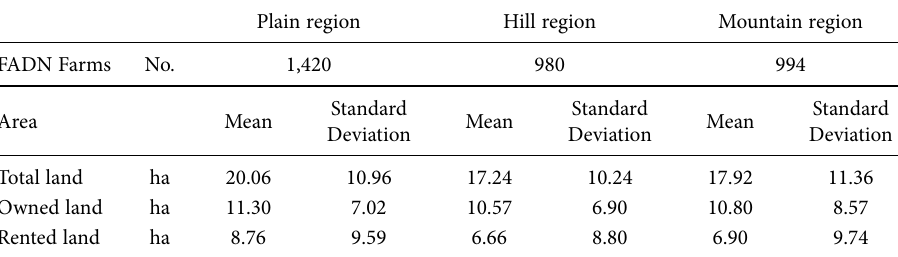
Table 3. Area of owned and rented farmland in the plain, hill and mountain regions. Plain region Hill region Mountain